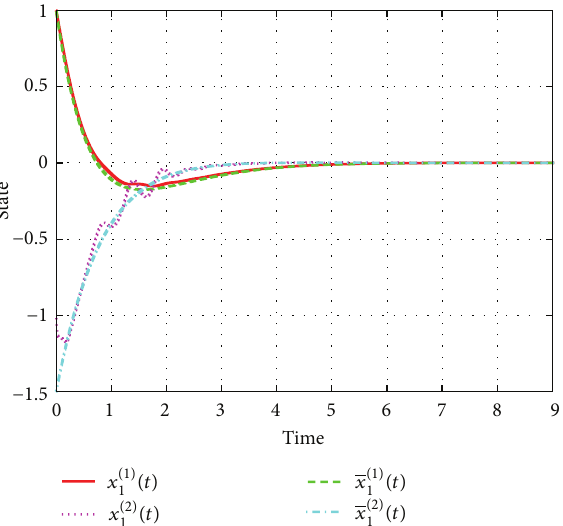
Figure 1: Time histories of 𝑥 1 (𝑡) and 𝑥 1 (𝑡) .